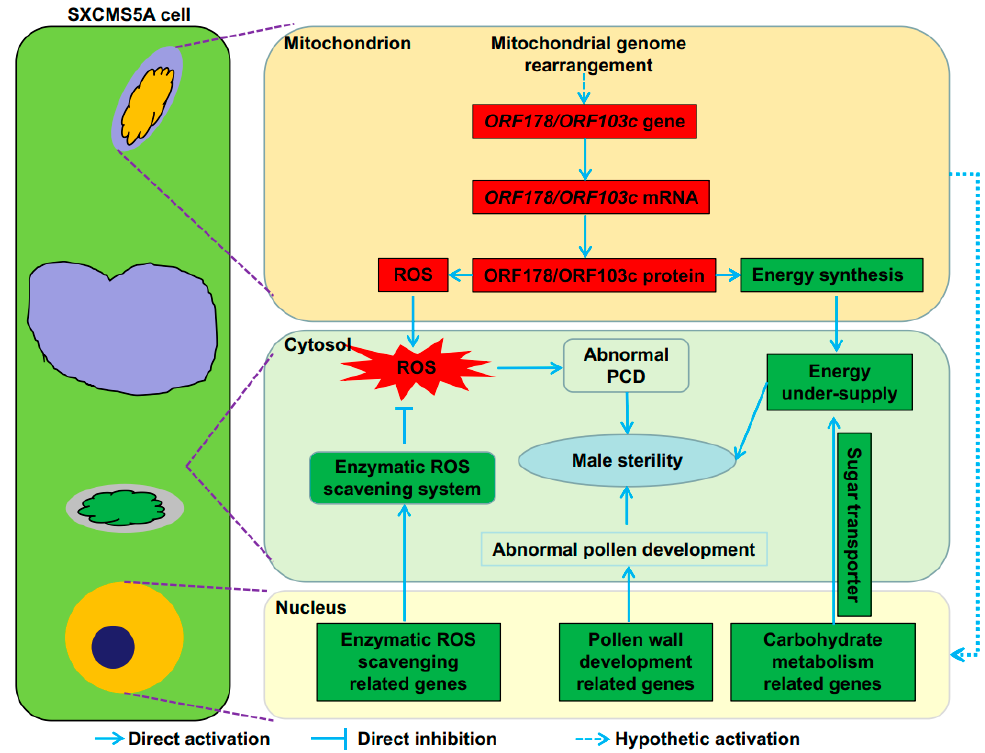
Figure 9. A proposed model for the mechanism of male sterility in soybean CMS line SXCMS5A. The upregulated and downregulated genes or metabolite contents are in red and green backgrounds, respectively.